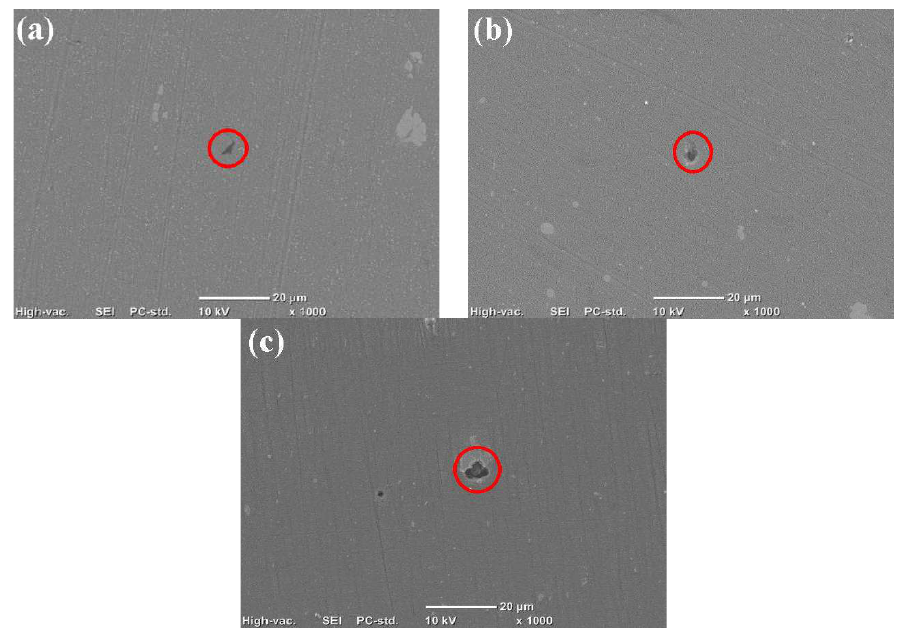
Figure 7. SEM images for comparison of microvoids in AA7050 during tertiary creep stage under 165 °C and different stress levels: ( a ) 300 MPa for 18 h; ( b ) 325 MPa for 8 h; and, ( c ) 350 MPa for 4 h.